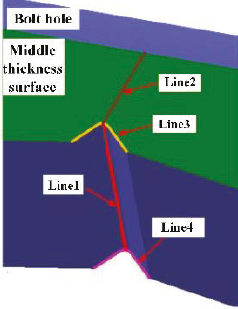
Figure 8. Feature lines.